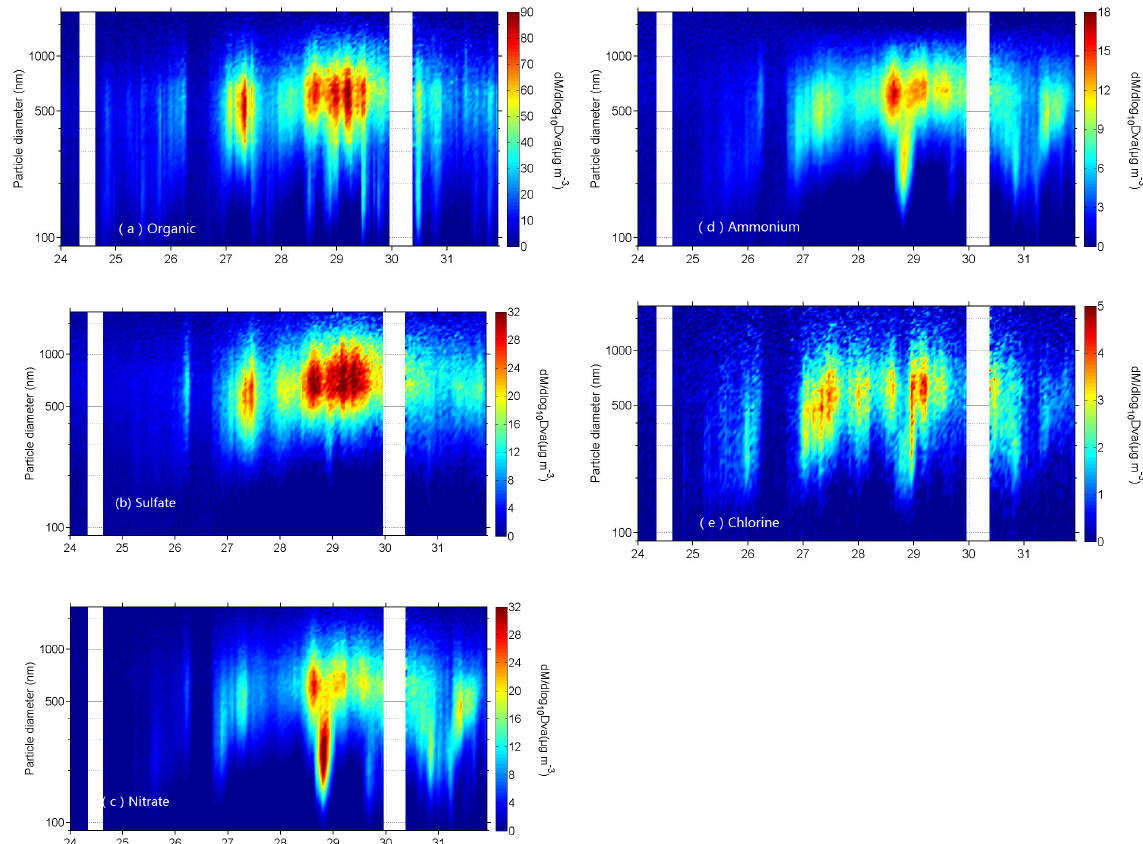
Figure 8. Size-resolved chemical compositions of (a) organic, (b) sulfate, (c) nitrate, (d) ammonium and (e) chlorine.